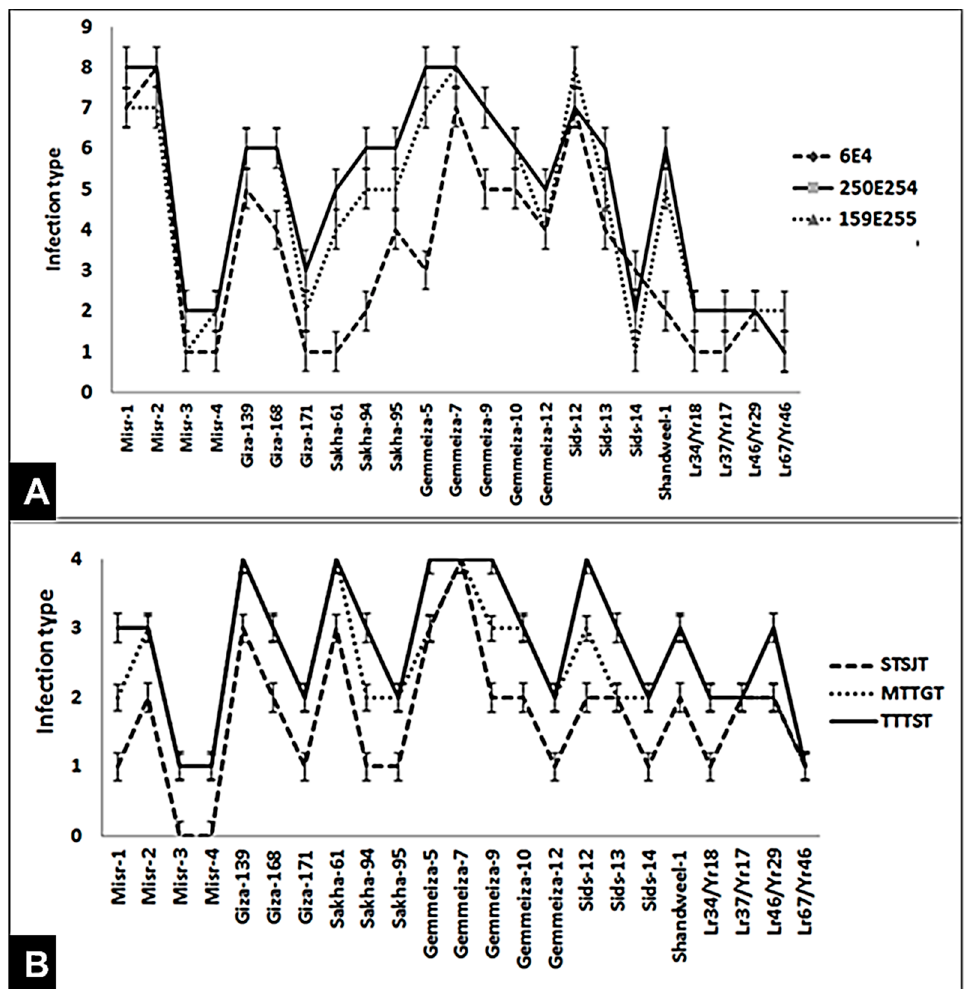
Figure 1. Seedling response of 23 wheat genotypes against the three races of stripe rust ( A ) and leaf rust ( B ) at seedling stage under greenhouse conditions.